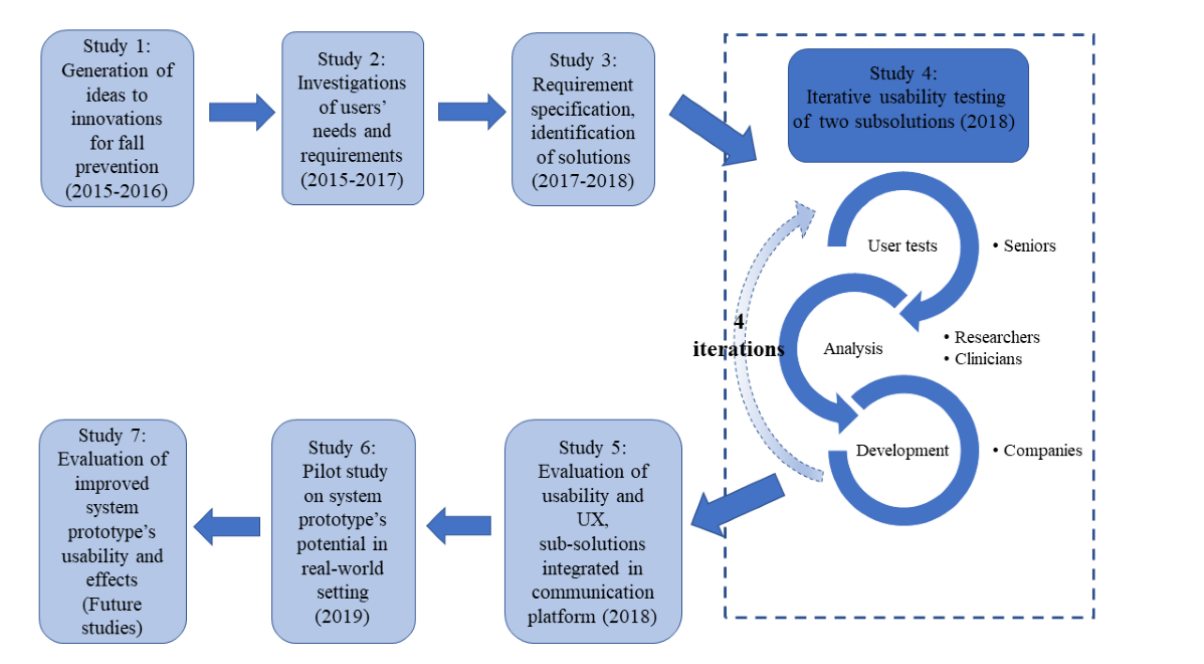
Figure 1. Overview of the user-centered design and the 7 studies (where study 7 represents several future studies) of the development of digital support for fall-preventive physical activity interventions in seniors. This protocol describes a method for systematic tracking of feedback from user subgroups used in study 4. UX: user